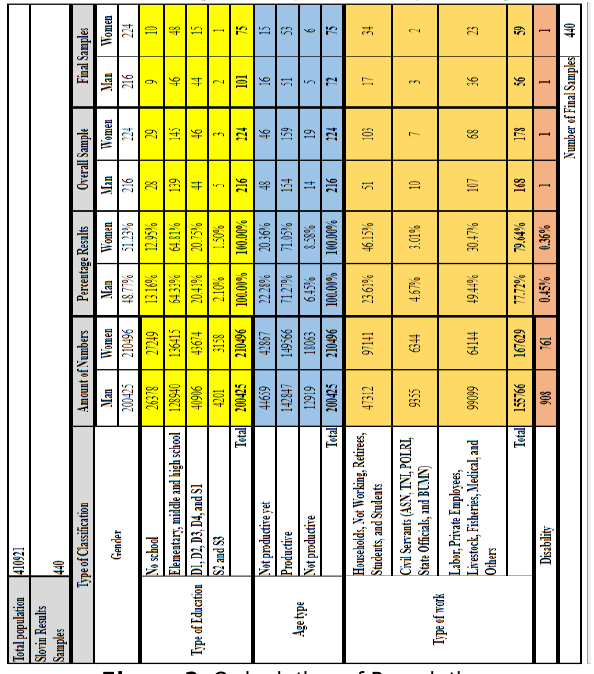
Figure 2. Calculation of Population